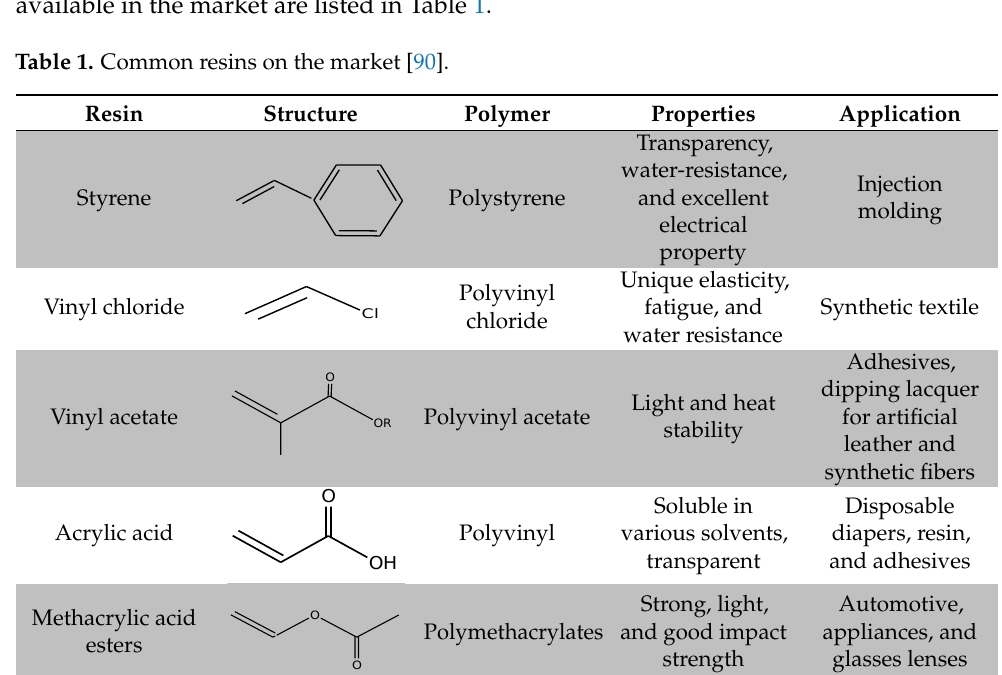
Table 1. Common resins on the market [90].